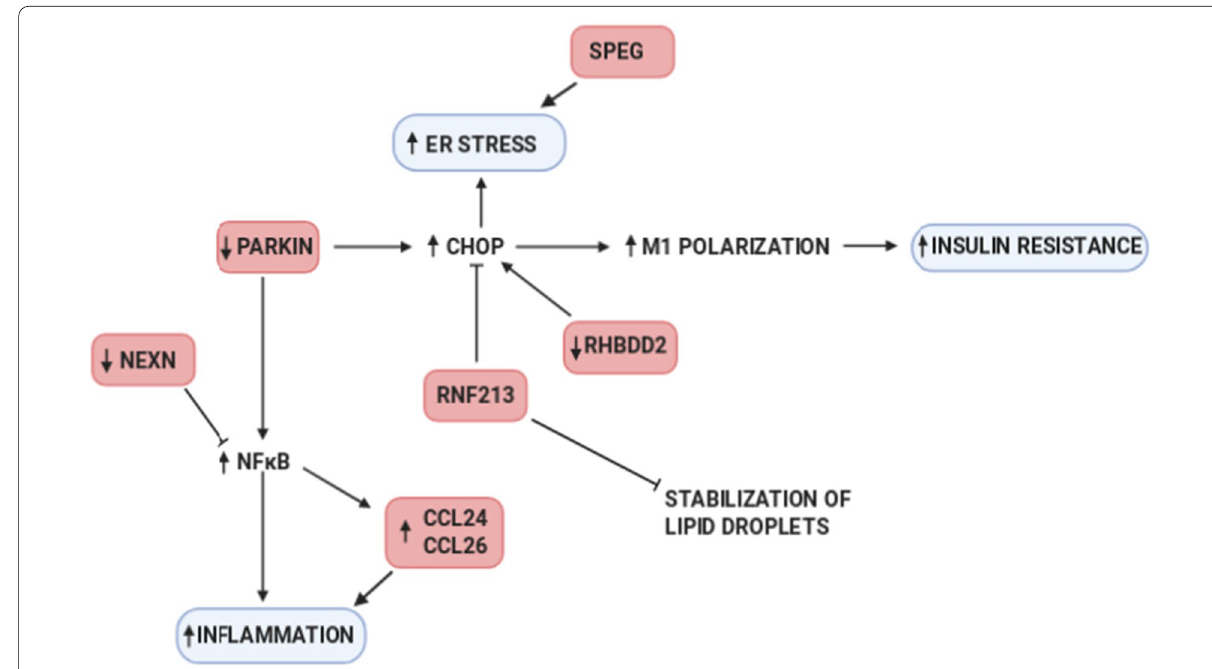
Fig. 5 The schematic representation of pathways (blue) affected by genes which variants associate with GWG